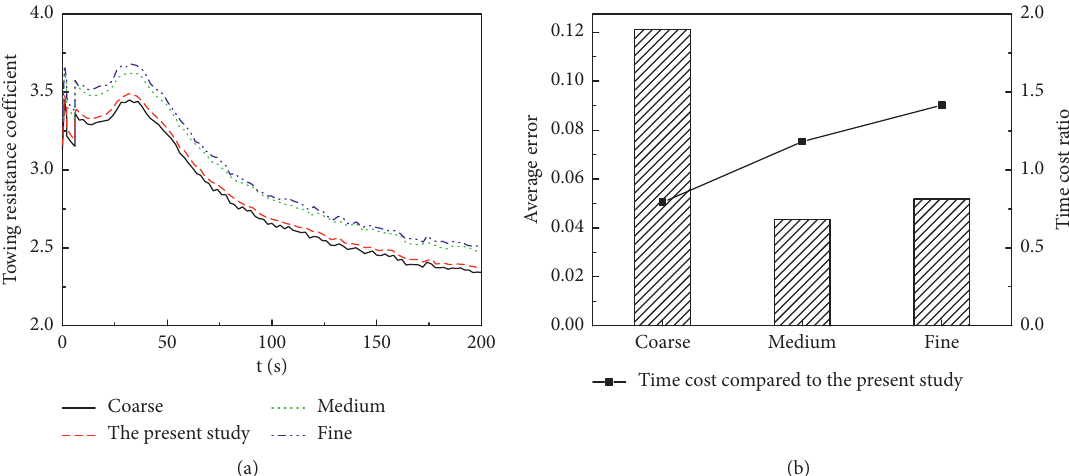
Figure 6: The towing performance comparisons of different mesh methods: (a) the time series of towing resistance coefficient at the towing speed of 4kN (represented by the speed of the fluid) and (b) the average error and time cost ratio statistics compared to the present study.